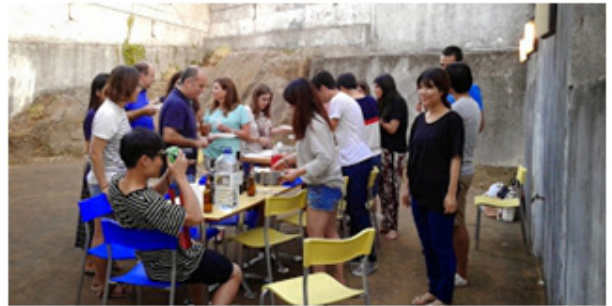
Figure 4. E4SD: Korean dinner in the students